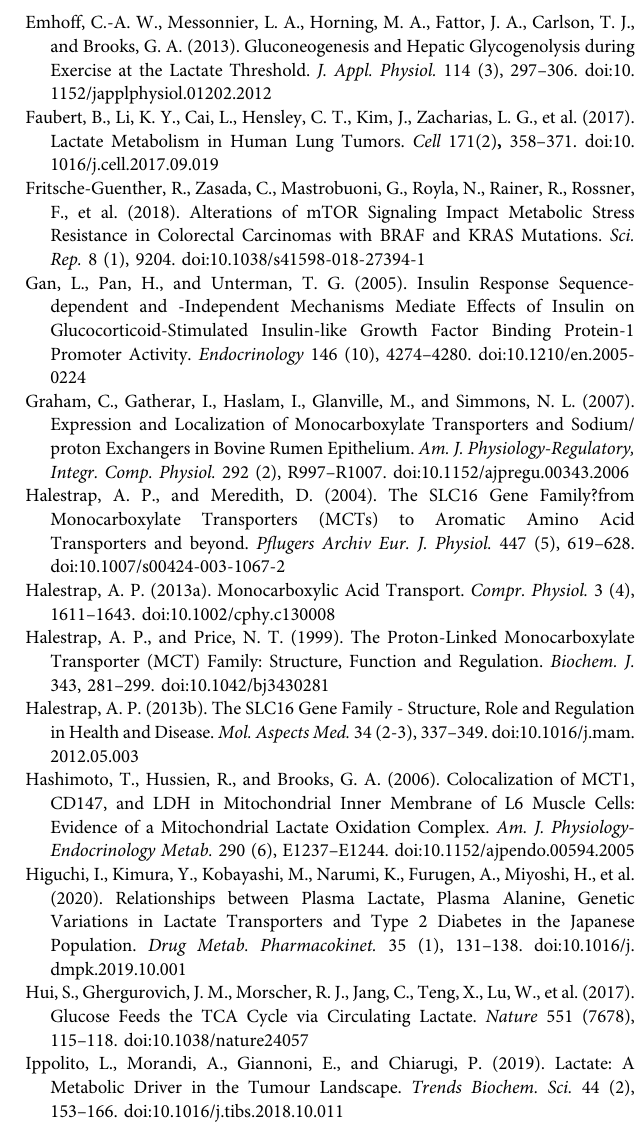
Supplementary Figure S1 | Correlation analysis of gene expression level. (A) Correlation of expression level among libraries; (B) Validation of DEG expression level by qPCR. Supplementary Figure S2 | Top greatest signi fi cantly enriched GO and KEGG cluster. (A) GO terms and (B) KEGG pathways. Supplementary Figure S3 | Ef fi ciency of SLC16A1 knock-down or overexpression. SLC16A1 relative expression levels in SLC16A1 (A) silencing or (B) overexpressing bovine hepatocytes. Supplementary Figure S4 | Effect of SLC16A1 silencing on transcription of genes related to lipid metabolism. (A) ACO1, lipid oxidation; (B) PPARG, metabolism; (C) DGAT1, synthesis; (D)